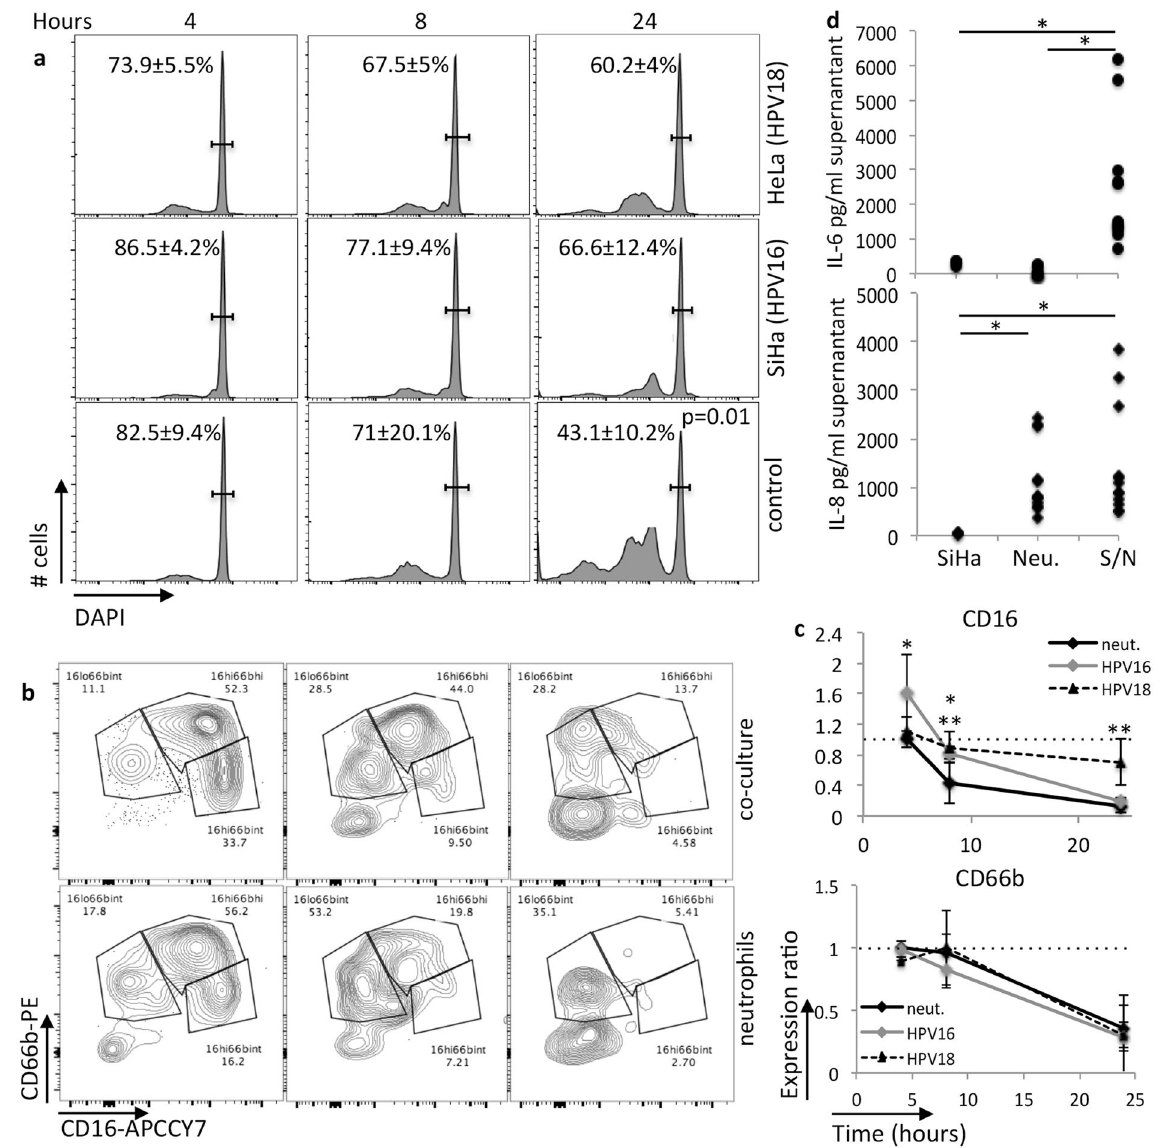
Figure 5. Cross-talk between cervical cancer derived cells and neutrophils. Neutrophils in co-culture with SiHa spheroids (co-culture) or in pure cultures (neutrophils) were evaluated at the indicated periods of time for: ( a ) viability, ( b ) CD66b and CD16 expression, and ( c ) cytokine production (only at 24 hours of culture). At each time point, cells and supernatants were harvested, cells were labeled with anti-CD45, CD66b, CD16, fixed and incubated with 10 μ g/ml DAPI for 30 min before flow cytometry analysis. A. DAPI fluorescence was measured in the CD45 + population. The gated cells in the histograms indicate DNA content corresponded to whole cells, events to the left, correspond to sub-G1 dead cells. Significant differences were found only at 24 hours of culture (p value indicated). Still within the CD45 + population, we evaluated frequency ( b ) and expression ratio ( c ), depicted as expression of CD66b and CD16 in co-cultures/expression in pure neutrophil cultures. The frequency plots are representative of one experiment, and the kinetic in the right side graphs are the average ratios obtained from all experiments. A total of 5 different blood samples were used in these experiments. The U-test Mann Whitney tested differences in CD16 and CD66b expression ratios through time; * indicates significant differences in CD16 expression between experimental conditions; dotted lines indicate ratio 1 for reference. ( d ) Cytokine production. Supernatants from 24 hours cultures were tested for cytokine production using the Human Inflammatory CBA kit, according to the manufacture’s instructions. Although this kit has antibodies for several cytokines, only IL-6 and IL-8 were secreted in concentrations above cut off values. SiHa – tumor cells spheroid supernatant, Neu. – neutrophils supernatant, S/N – SiHa spheroids and neutrophil co- cultures. We tested the results using one-way ANOVA, * indicates significant differences between experimental